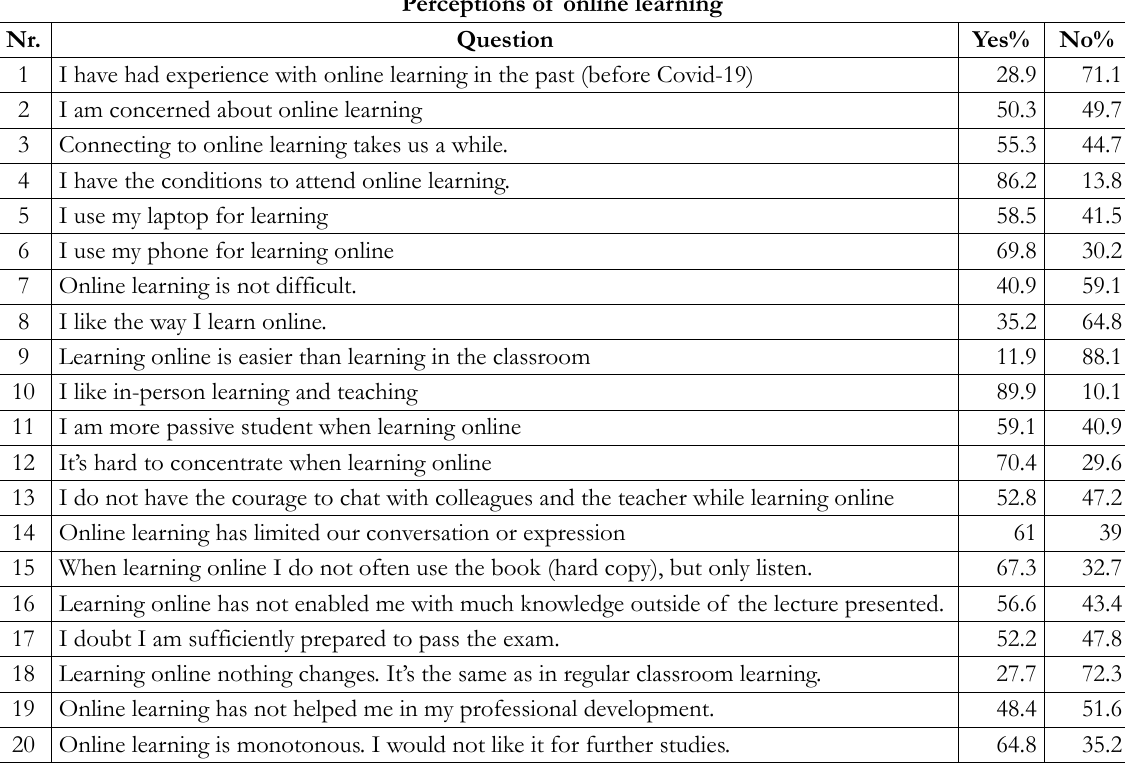
Table 2. Future teachers’ Perceptions of Online